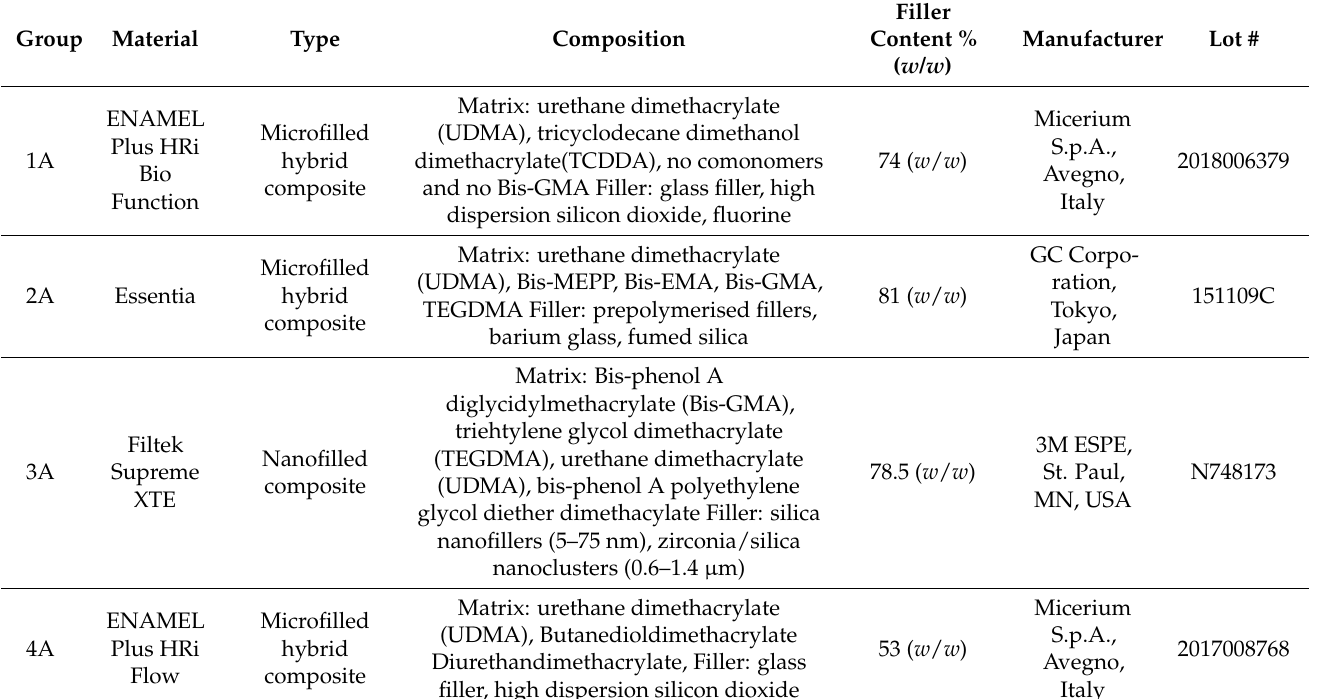
Table 1. Composite resins tested in this